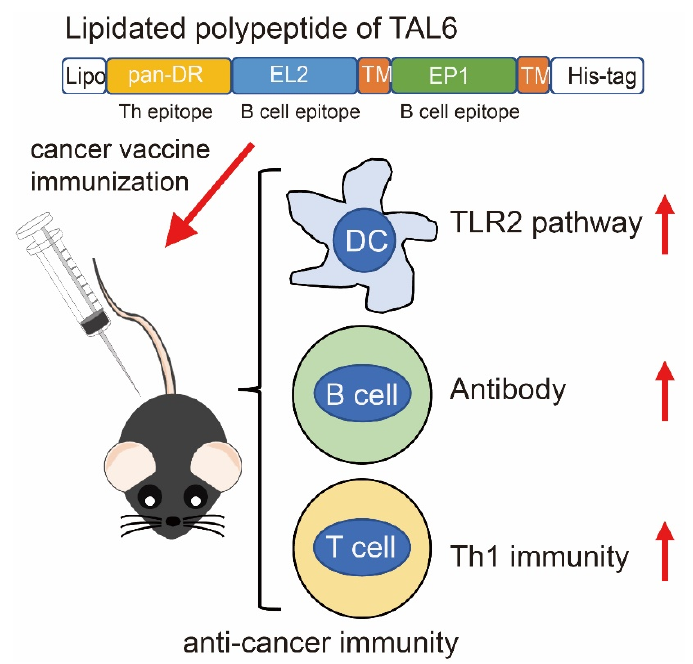
Figure 8. Mode of action of the lipidated polypeptide of TAL6. This cancer vaccine immunization elicits anti ‐ cancer immunity, including TLR 2 signaling for DC activation, antigen ‐ specific antibody production, and Th1 immunity.